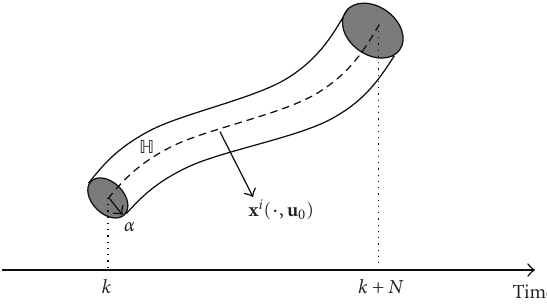
Figure 4: A tube around a nominal trajectory, of vehicle